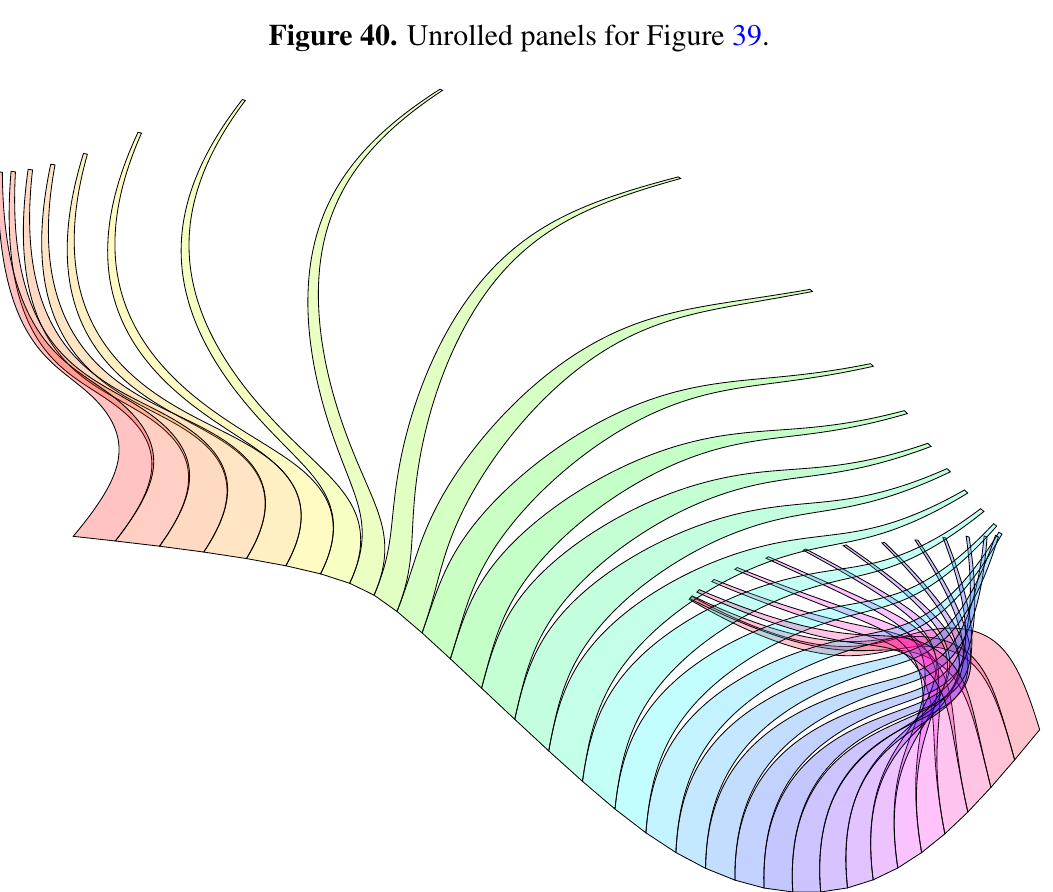
Figure 40. Unrolled panels for Figure